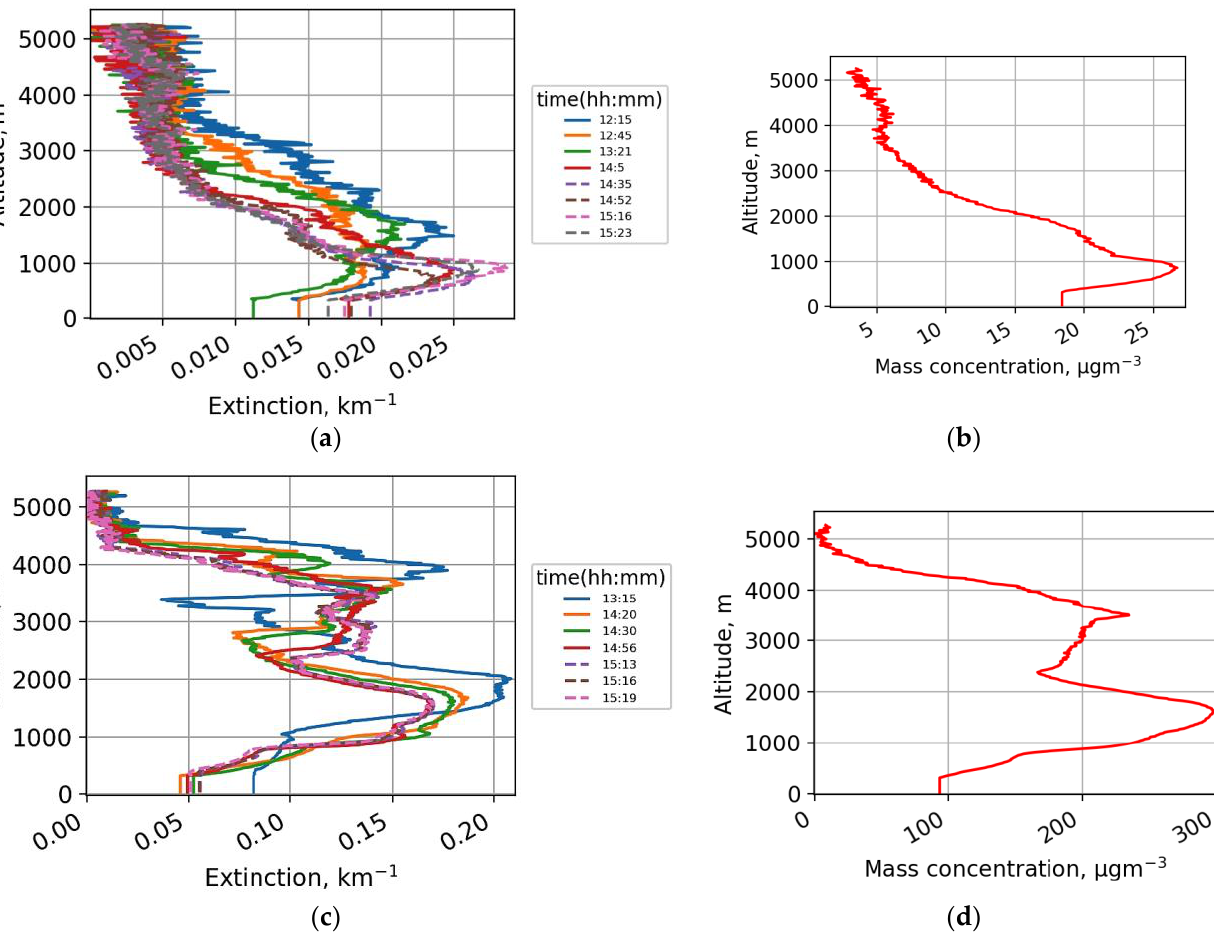
Figure 9. Extinction altitude profiles on ( a ) 21 April in the period from 12 h 15 m until 15 h 23 m and ( c ) 25 April in the period from 13 h 15 m until 15 h 19 m; average mass concentration altitude profiles on ( b ) 21 April and ( d ) 25 April in the atmosphere over Nicosia.